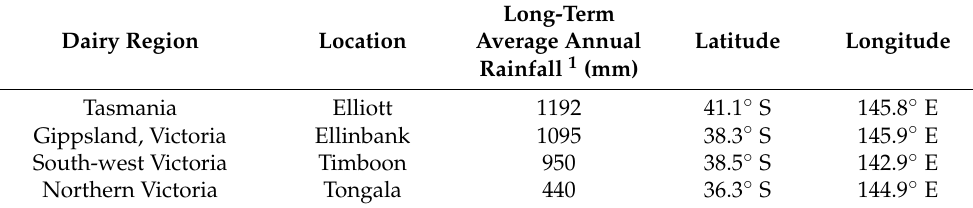
Table 1. Location of cultivar evaluation trials in south-eastern Australia.